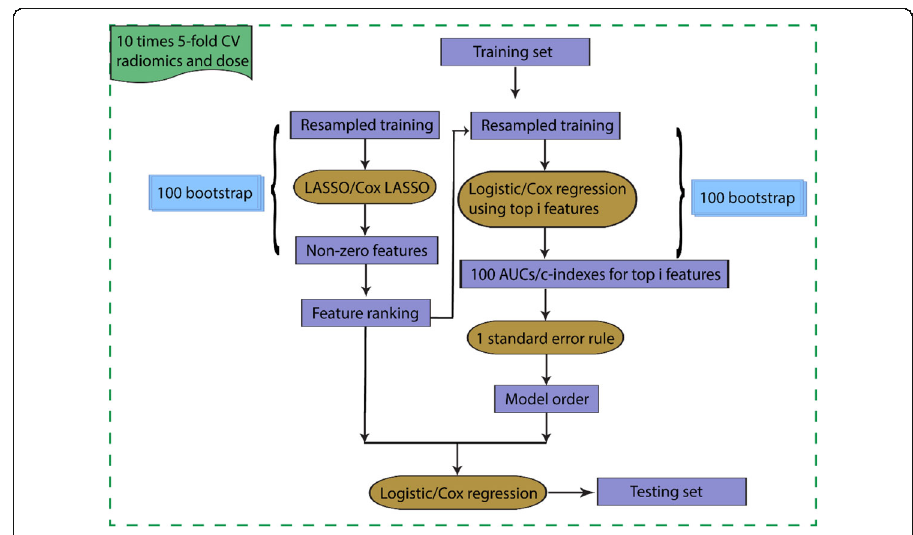
Fig. 1 Summary of radiomics model construction and